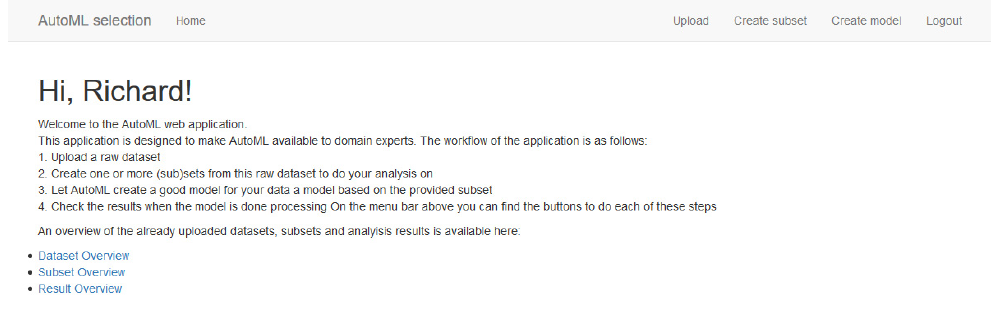
Figure C1. Screenshot 1 of of AutoML artefact A, the Web application interface (preference: GUI).